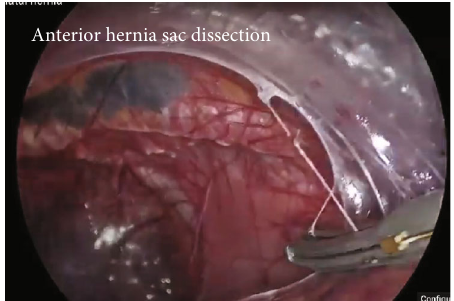
Figure 3: Video screenshot: anterior dissection.